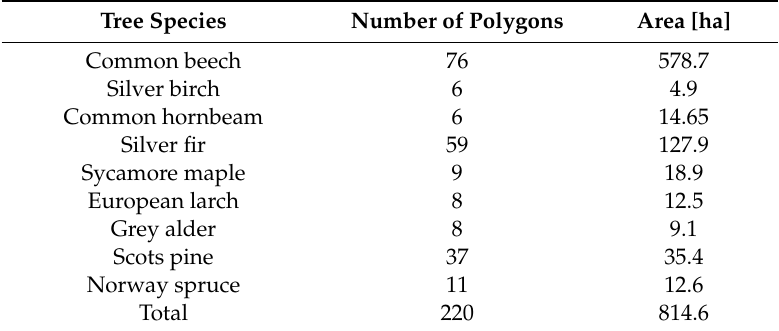
Table 1. Reference